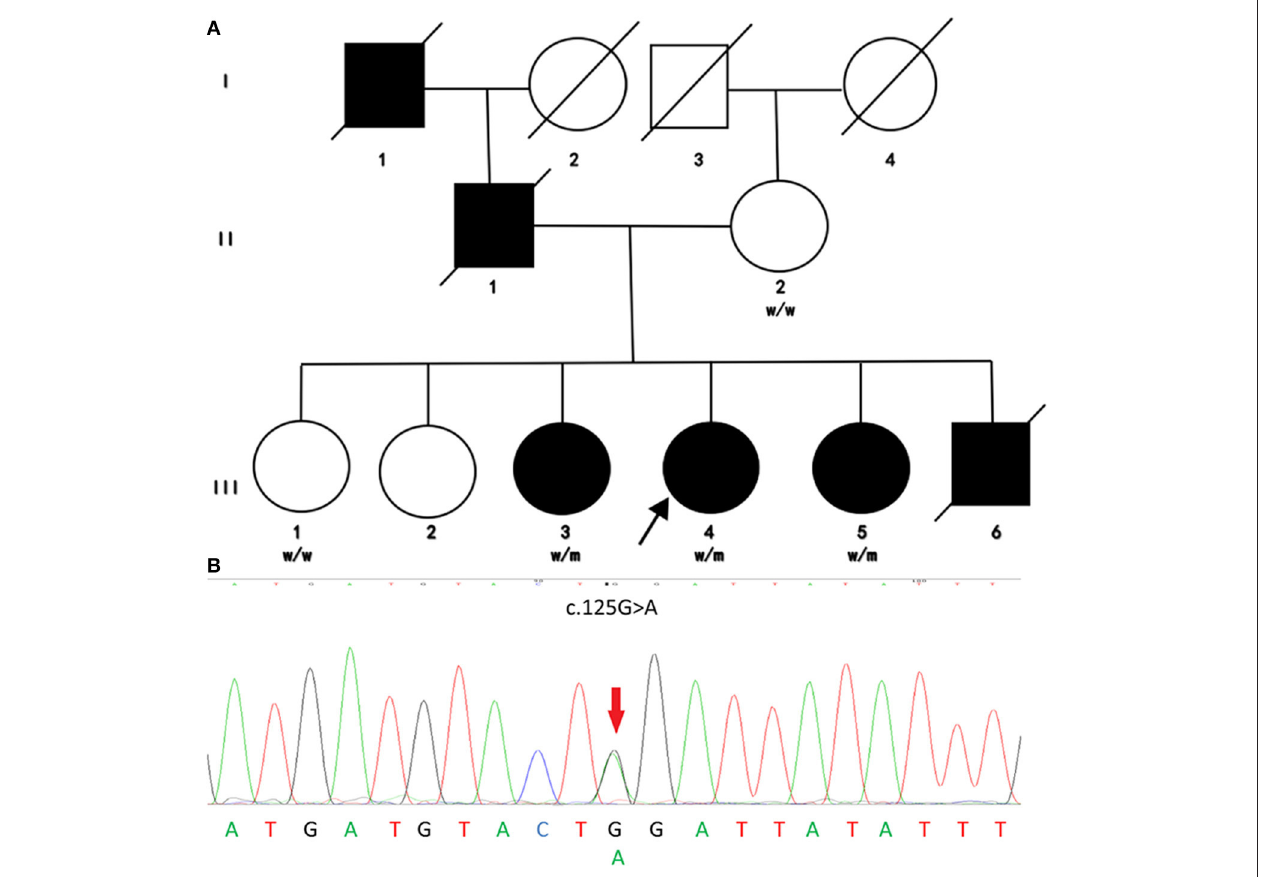
FIGURE 1 | Family pedigree and genomic sequencing electropherograms of the investigated HSP family. (A) Pedigree of the investigated family. Males and females are represented by squares and circles, respectively, and filled and unfilled symbols represent affected and unaffected individuals, respectively. The crossed symbols indicate deceased individuals. W, wild type; M, mutated. (B) Genomic sequencing electropherograms. The c.125G > A(p.Trp42*) heterozygous non-sense mutation of REEP1 was detected in this HSP family. This mutation cosegregated with an early-onset pure HSP phenotype, supporting the notion that this mutation is pathogenic for